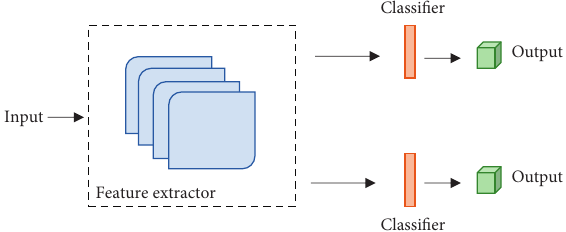
Figure 4: A multioutput (or multihead) model. In our study, as feature extractor, we used a pretrained convolutional neural net- work; as classifier, we adopted a fully connected layer.